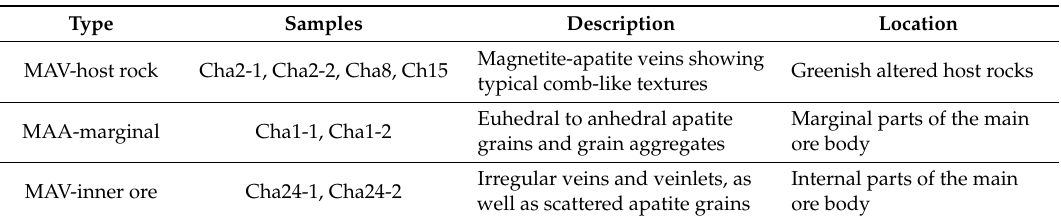
Table 1. Classification of the samples representing three different apatite types and their locations, in the Chadormalu